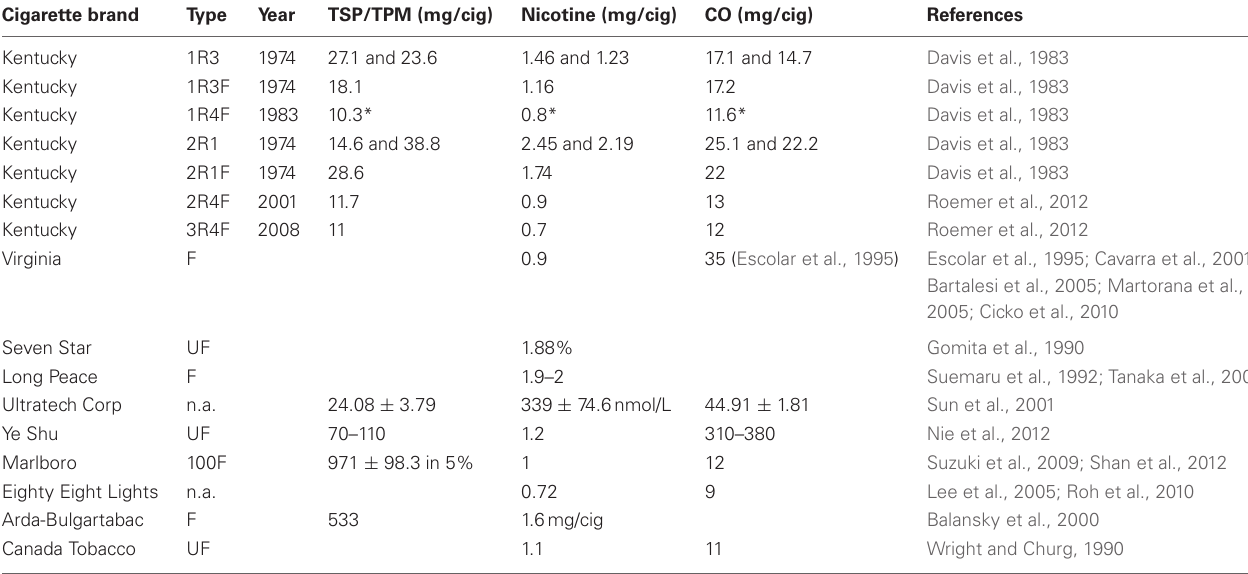
Table 4 | Cigarette types used for the summarized